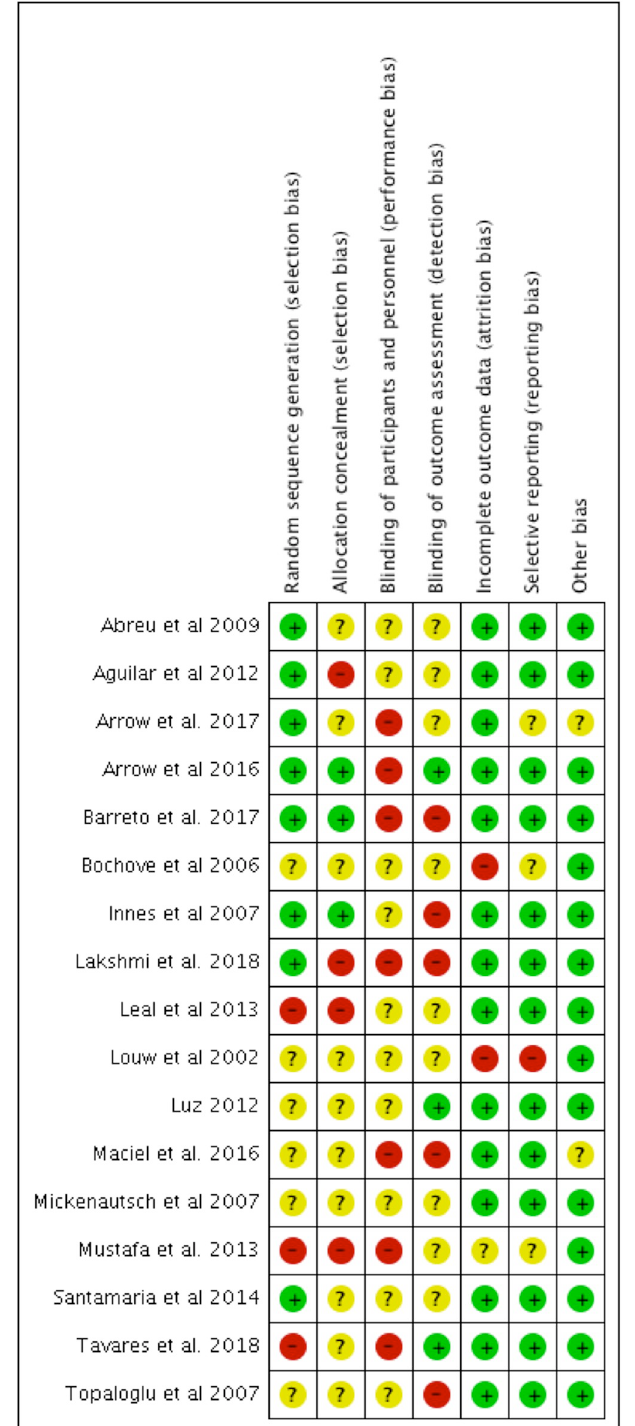
Fig 2. Risk of bias assessment using the Cochrane Collaboration Tool.